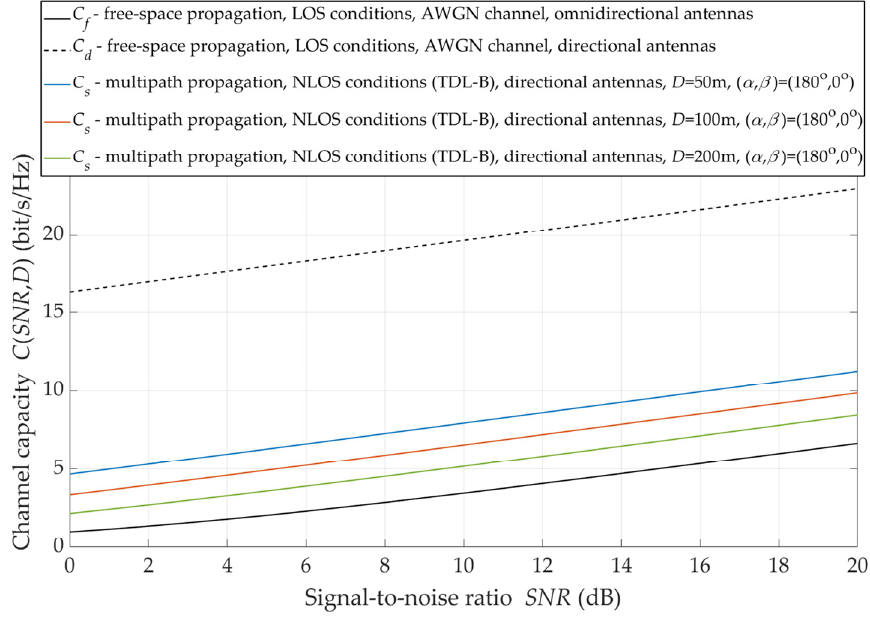
16 of 22 Figure 10. Capacity versus SNR for omnidirectional antenna pattern and different propagation con- ditions. The obtained results are a graphical representation of Equations (1) and (6). For mul- tipath propagation, the e K coefficient is determined based on Equations (4) and (5), where LOS and NLOS propagation conditions are determined by the PLE values equal to 2.1 PLE =